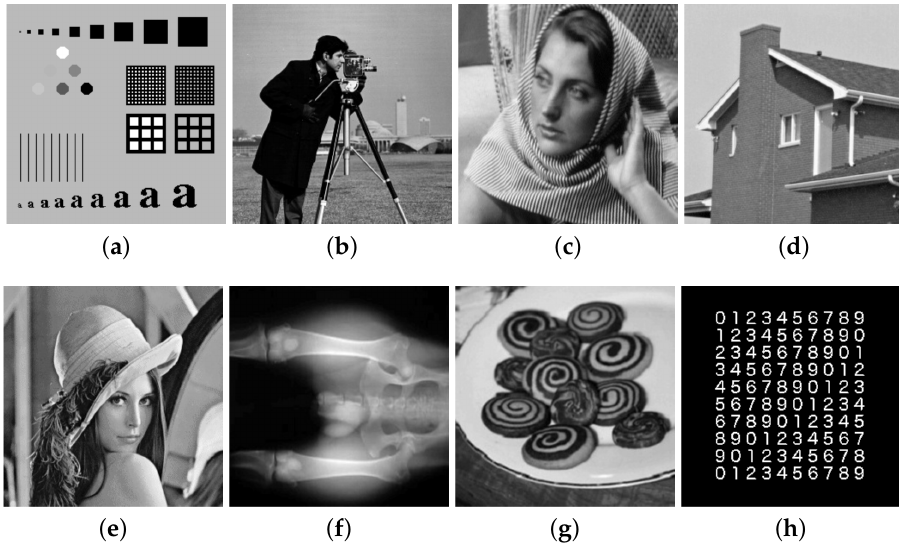
Figure 1. Original images of size 256 × 256. ( a ) Phantom; ( b ) Cameraman; ( c ) Barbara; ( d ) House;